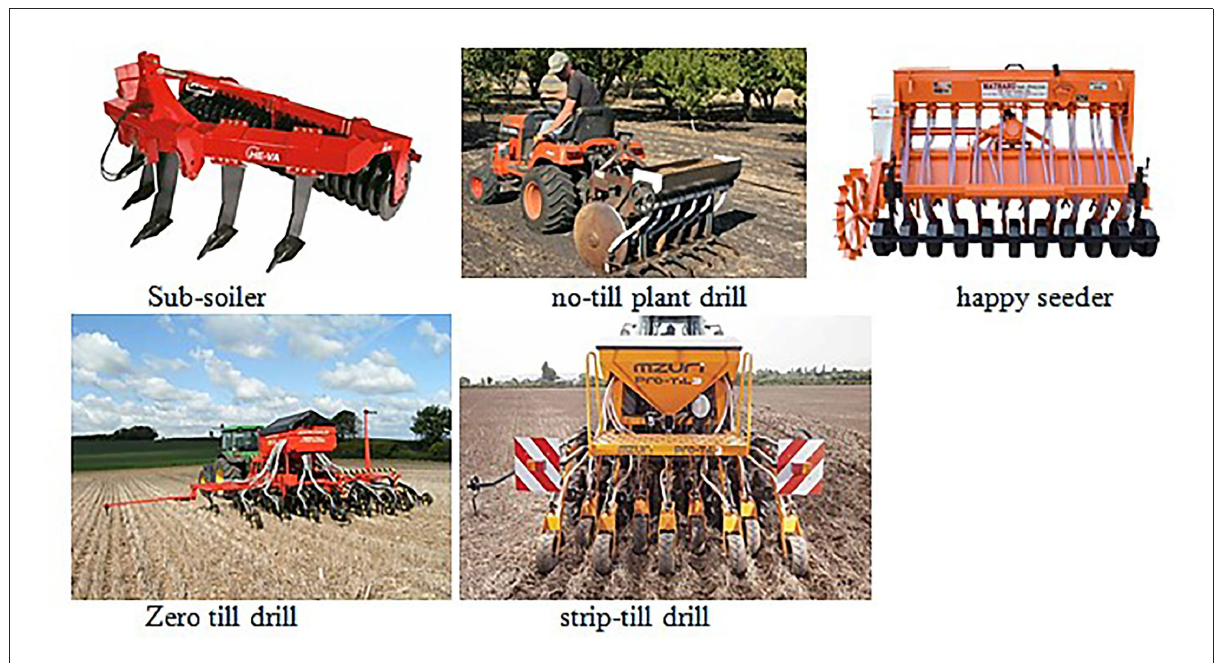
FIGURE6 Soil conservation equipment. Source: google images.